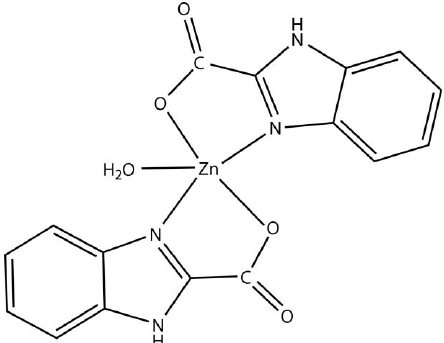
software used to prepare material for publication: CrystalStructure (Rigaku,